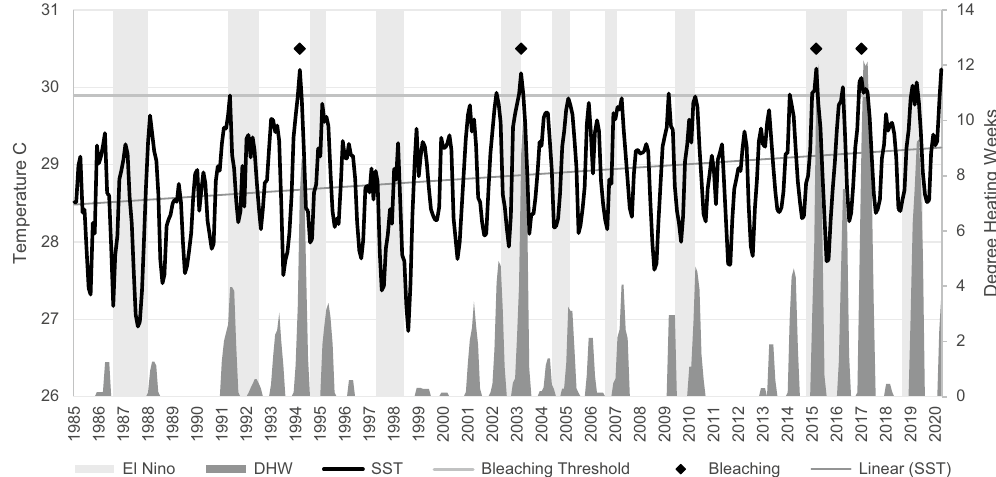
Figure 1. 1985–2020 time series of monthly average sea surface temperature (SST). Data is derived from the NOAA Coral Reef Watch virtual station for the Samoan Archipelago 9 and plotted against bleaching threshold, degree heating weeks (DHW, degree C-weeks), and El Niño events 12 . Degree heating weeks is a measure of accumulated heat stress in reef ecosystems and values greater than 8 C-weeks indicate potential bleaching conditions. Diamonds indicate observed bleaching events. Data was imported and processed in Microsoft